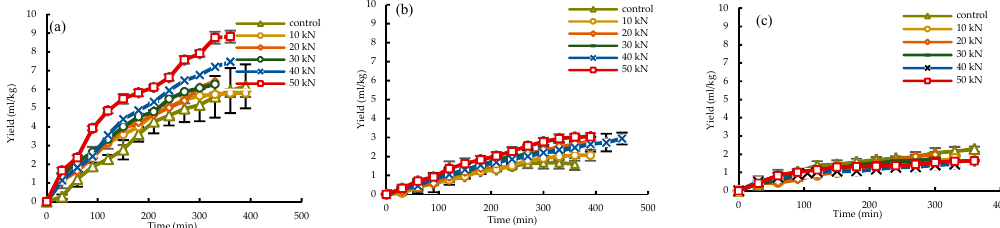
Figure 4. The yield of EOs extracted by steam distillation from residual forest biomass densified into bundles for ( a ) BF, ( b ) BS, and ( c ) JP.